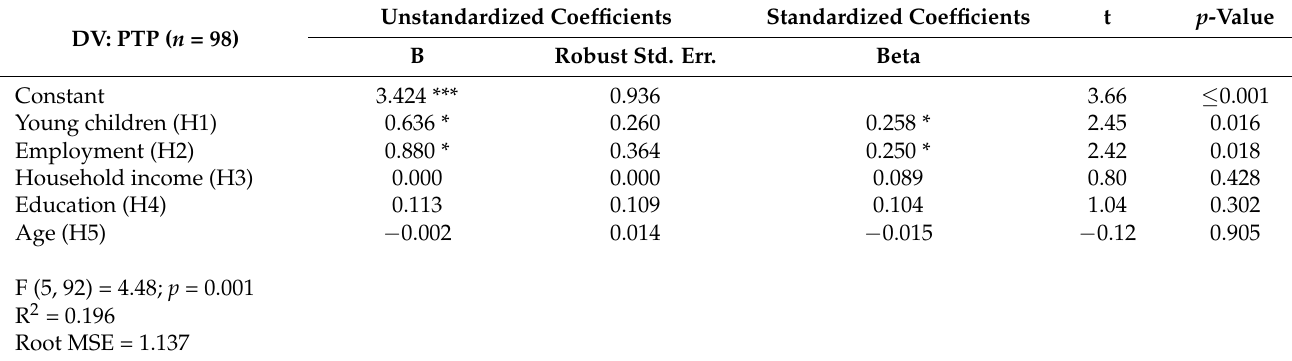
Table 6. PTP for the